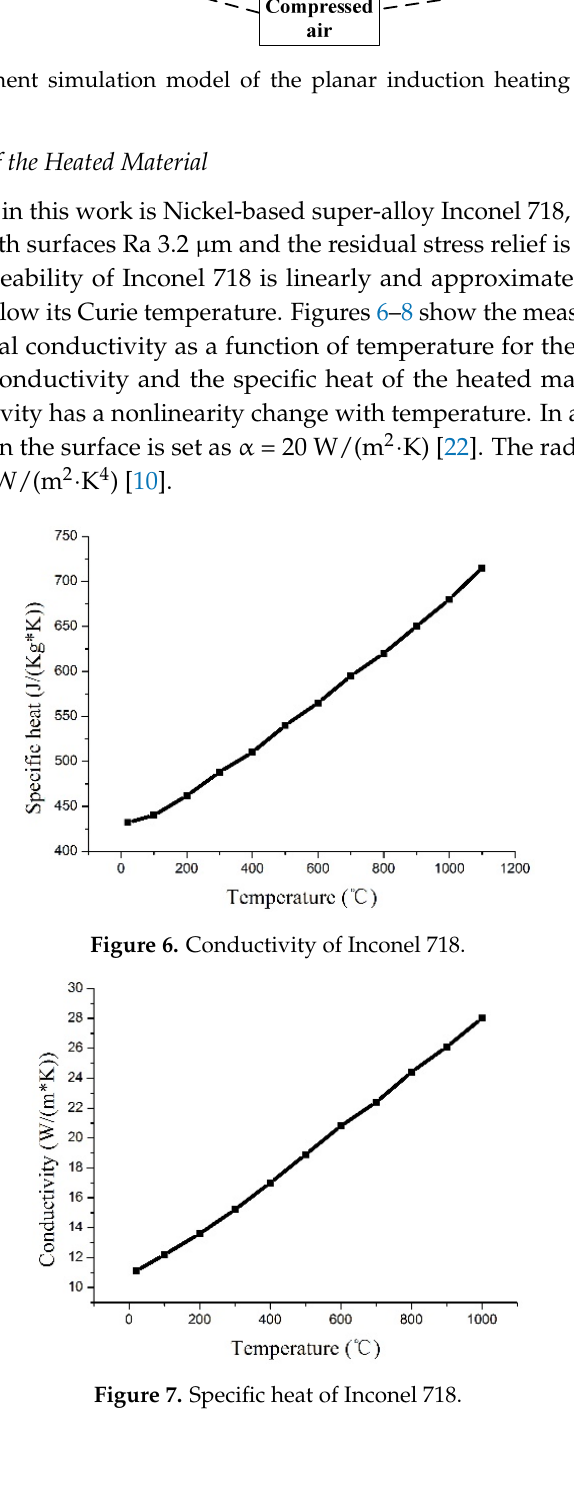
Figure 5. Finite element simulation model of the planar induction heating with magnetic flux concentrator (MFC).